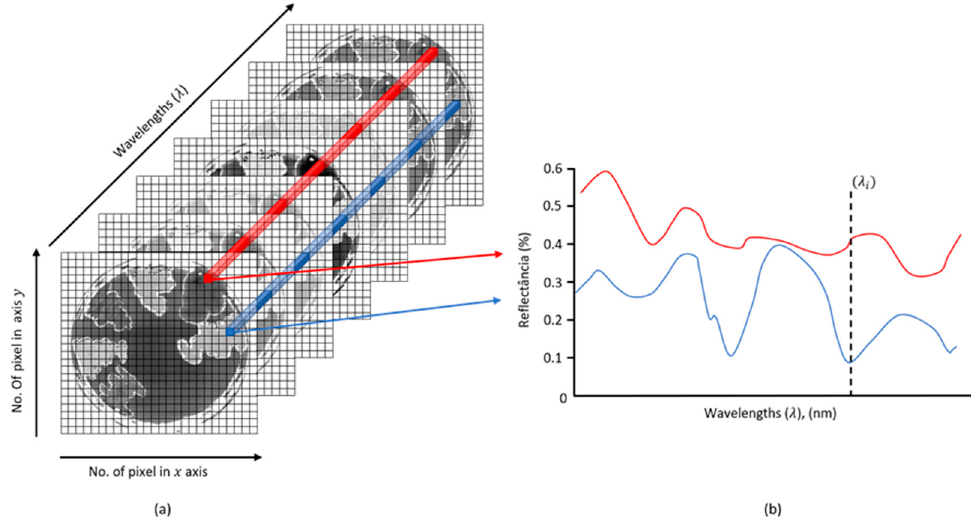
Figure 1. Schematic representation of an ( a ) HSI of multiple bacteria culture in a Petri dish and ( b ) a spectral signature of two different pixels on the hypercube image.